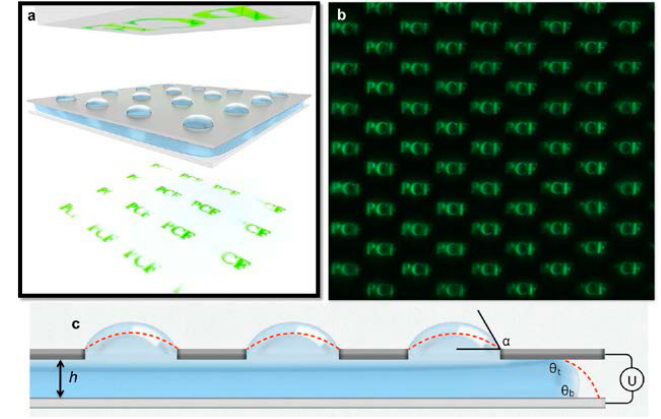
Figure 6. ( a ) Schematic representation of a microlens array. The PCF logo imaged from the top. ( b ) Array of PCF images formed by individual microlenses. ( c ) Side view of the microlens array. Application of voltage U modulates the contact angle of the sandwiched liquid on the bottom substrate, consequently altering the lens angle α , which in turn changes the curvature and the focal length of the pinned droplet. With kind permission of the Optical Society of America (OSA). Adapted from Murade, C.U.; van der Ende, D.; Mugele, F. High speed adaptive liquid microlens array. Opt.